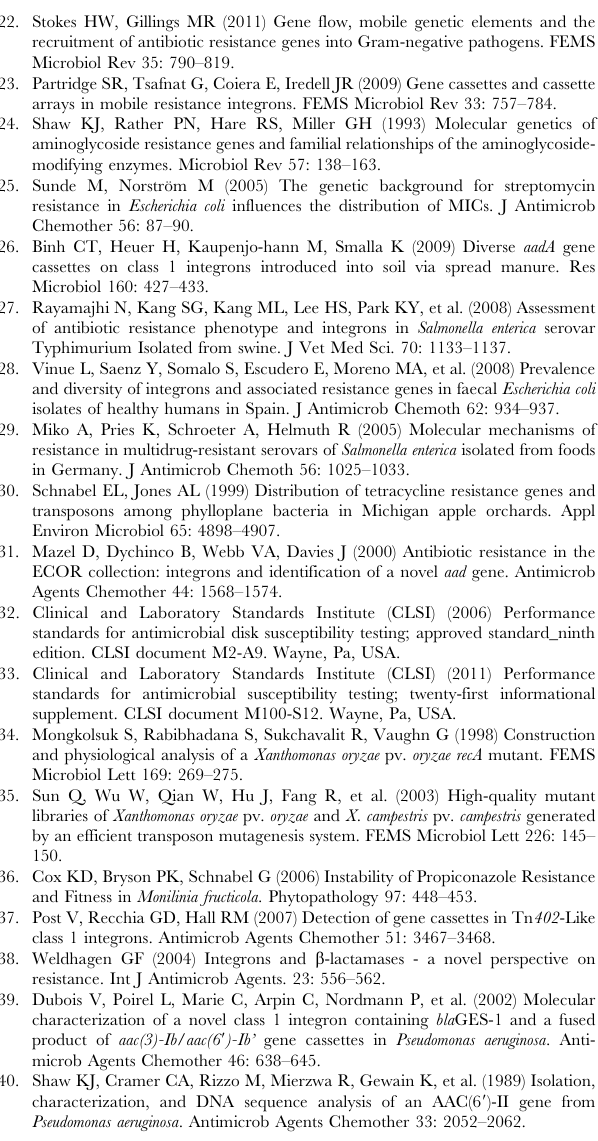
Table S2 Stability of streptomycin-resistance pheno- type and the aadA1 and intI1 gene in resistant isolates